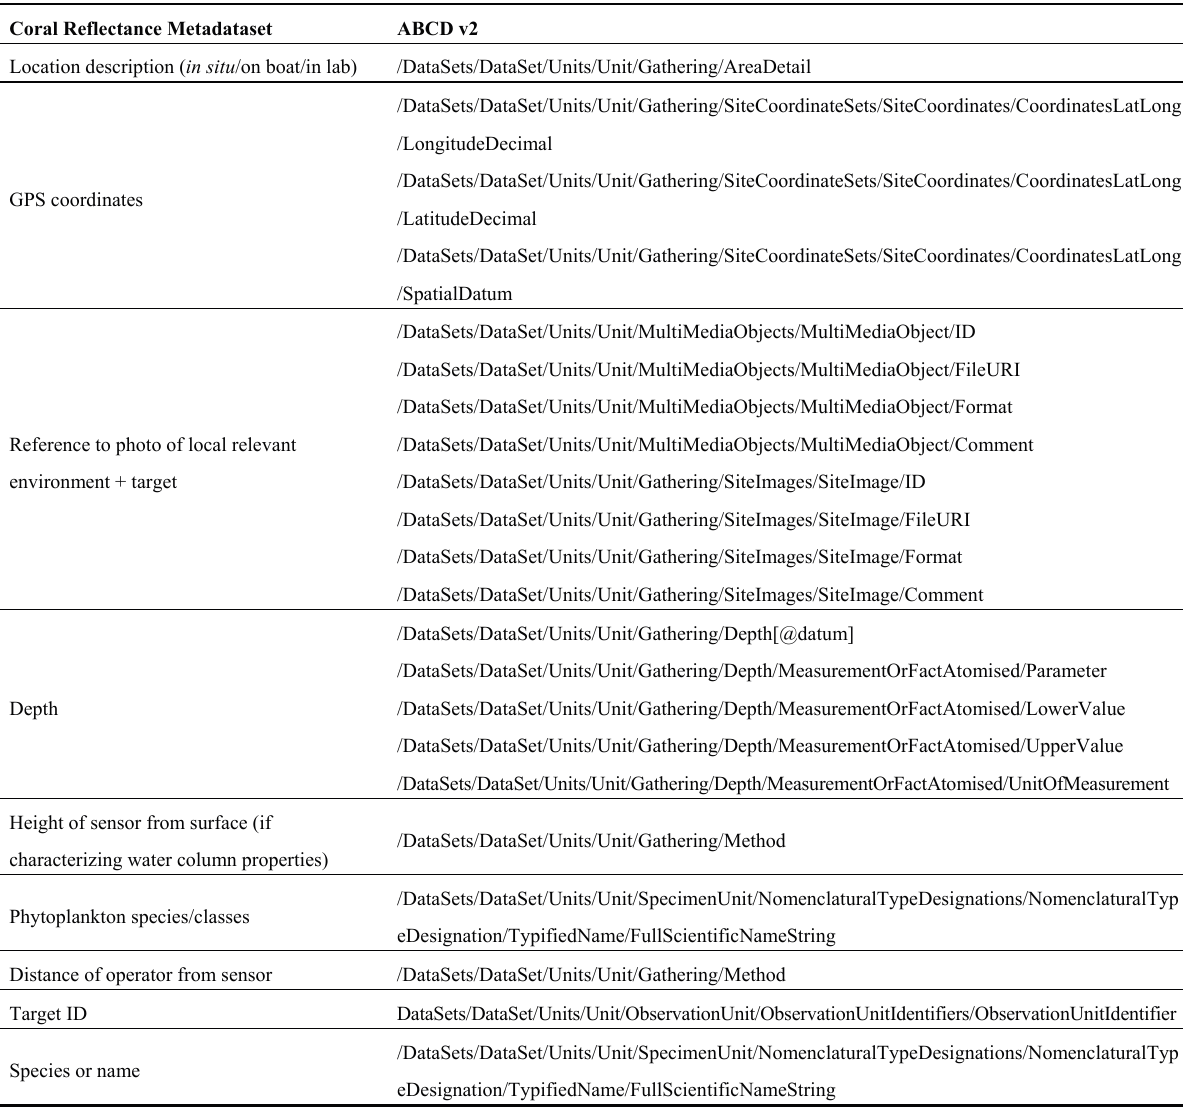
Table A8. Mappings from Access to Biological Collections Data Schema 2.06 to the underwater benthic reflectance metadataset.